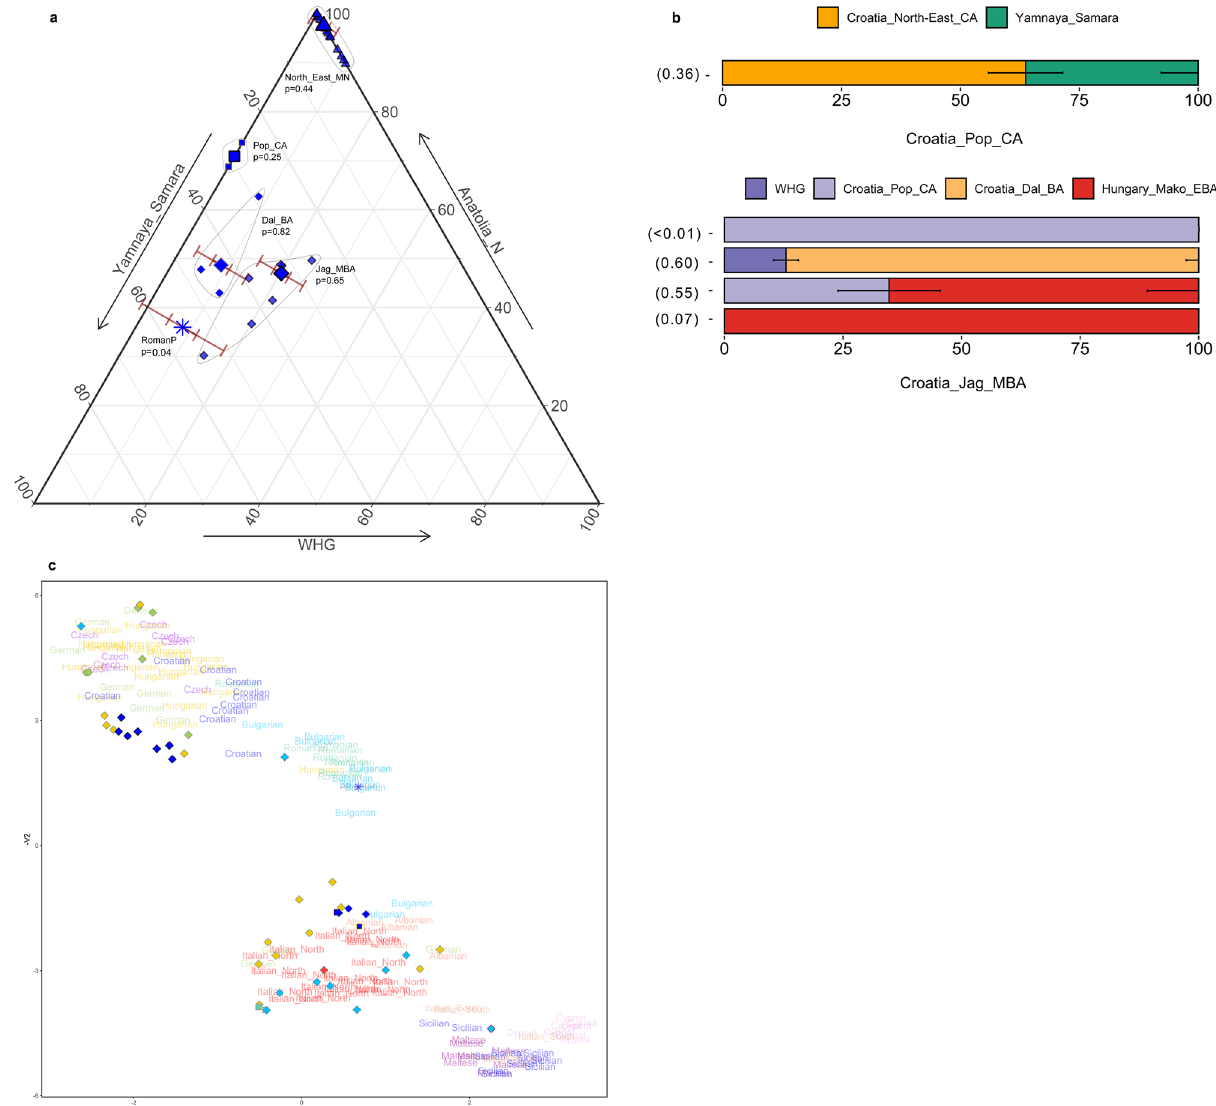
Figure 3. Admixture and genetic affinities in ancient Croatian genomes. ( a ) Distal admixture models obtained with qpAdm for ancient Croatian genomes (Source data in Supplementary Table S4). Smaller points represent individuals and larger points represent population groups with one and three standard error bars indicated for the WHG component. Each population group is labelled with its p-value and the group is encircled for clarity. Croatia_North-East_MN results are for nested two-way models with sources WHG and Anatolia_N, Croatia_Pop_CA is modelled with Anatolia_N and Yamnaya_Samara, and the remainder are three-way models using sources WHG, Anatolia_N and Yamnaya_Samara. b ) Proximal admixture models for Croatia_Pop_CA and Croatia_Jag_MBA using qpWave and qpAdm (Source data in Supplementary Table S4). Error bars are one standard error in each direction. ( c ) UMAP plot of selected post-Neolithic genomes from southern and central Europe. Present-day populations from the Human Origins dataset are indicated with text; ancient genomes are indicated with points as per PCA symbols in Fig. 2. All plots were produced using R 3.5.2 102